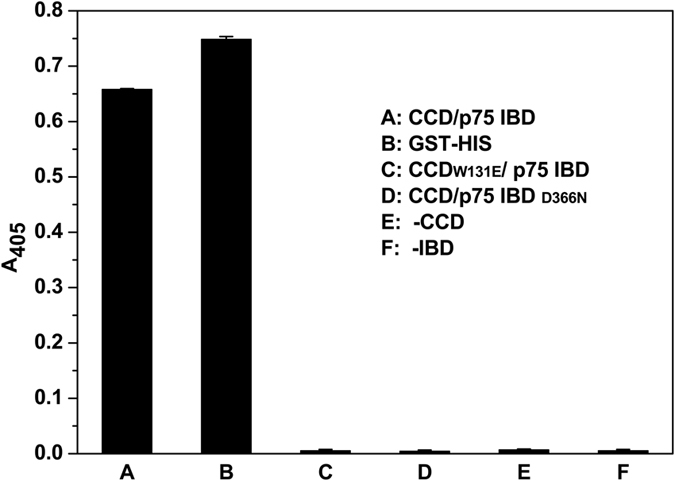
Assay performance under optimal reaction conditions.Signal was obtained as A405. Error bars represent SD from 3 replicate values. The S/N, S/B and z′ factor values of the assay were 326, 146 and 0.98 respective, which exceeded the minimum criteria (S/N >10, S/B >3 and z′ >0.5). These values of statistical parameters reflected that the assay developed showed high sensitivity, specificity, and robustness and was suitable to be developed for high-throughput screening (HTS).